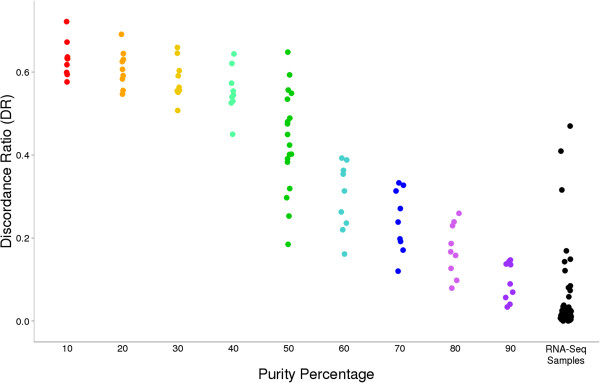
Simulated contamination of RNA-Seq reads. Sample contamination was simulated by mixing RNA-Seq reads from two different samples in controlled ratios. These intentionally contaminated samples’ RNA genotypes were then compared back to the DNA genotypes from which they were mixed. Specifically, a Purity Percentage of ‘10’ indicates that 10% of the reads in that RNA genotype file were sampled from the DNA sample to which it was compared.